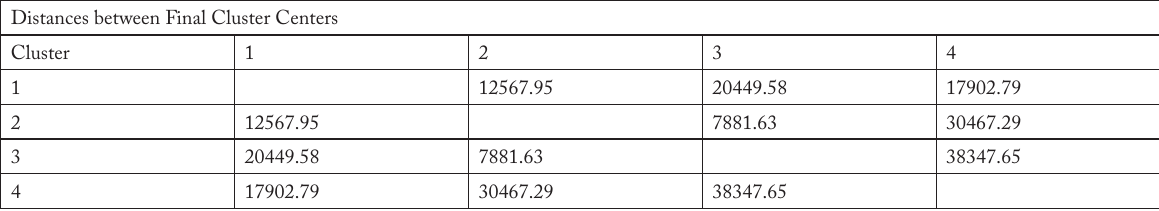
Table 2. Distances between Final Cluster Centers according to the k-means clustering.